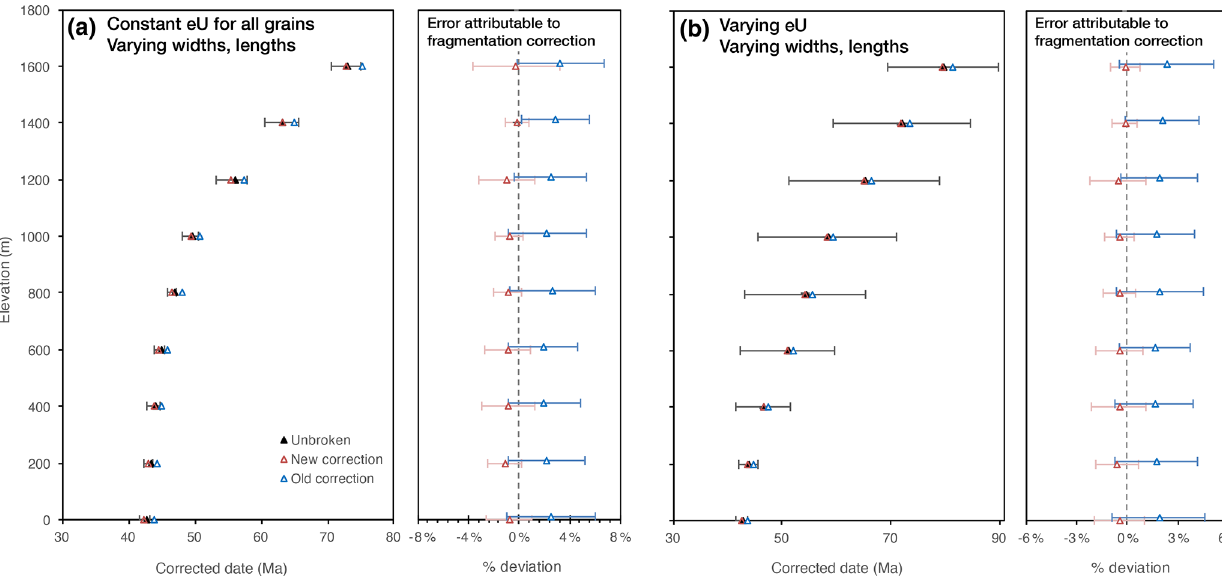
Figure 6. (a) Date-elevation transect of a crustal block that cooled slowly through the partially retention zone and was subsequently rapidly exhumed (see Brown et al., 2013, Fig. 9), showing fragment dates corrected using the new protocol (red) and the previous protocol (blue), and the expected whole-crystal date (black). Note that the red and black triangles may be difficult to distinguish because they overlap in most cases. Corrected dates are from fragments of varying lengths, both singly and doubly broken, that were generated from crystals with variable widths and lengths but constant eU. Error bars in the date-elevation transect represent intra-sample date dispersion and are shown for the new protocol only. Error bars in the right panel show the % deviations of the fragment dates corrected using the new (red) and old (blue) protocol from their corresponding corrected whole-crystal dates. (b) Same as (a) , but the fragments were generated from crystals of varying eU (15–100ppm, Brown et al., 2013), in addition to varying width and length. Notice that the introduction of eU as a variable significantly increased the intra-sample dispersion of corrected dates, but that the error attributable to the fragmentation correction alone was not materially affected. All error bars are 1 σ